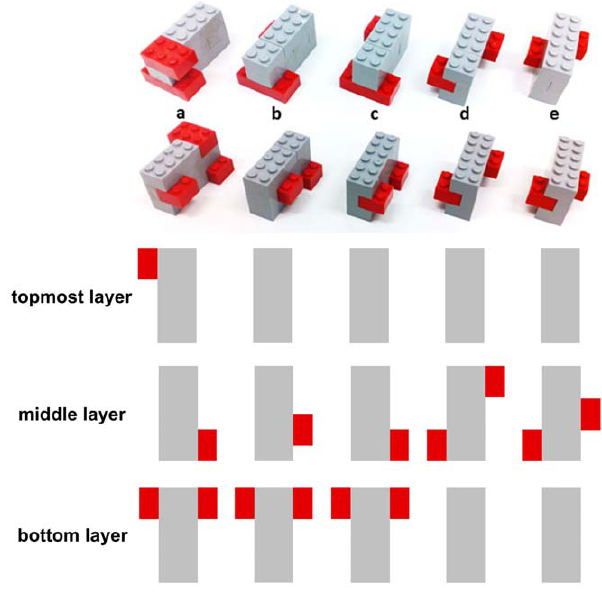
Figure 5. Objects used for the haptic object recognition test. Five groups of unfamiliar objects made from LEGO TM bricks were used for the haptic object recognition test (upper row of photo: view from the backside; lower row of photo: view from the front). In each group, the objects consisted of a cuboid (1.5 * 2.7 * 4.7 cm) with a specific number and position of rectangular structures (each 1.6 * 0.8 * 1 cm (4 in group a; 3 in group b and c, 2 in group d and e)) on the sides (marked in red, c.f. schematic drawing). A total of 17 objects (3 * a, 5 * b, 4 * c, 3 * d, 2 * e) were used for the test.